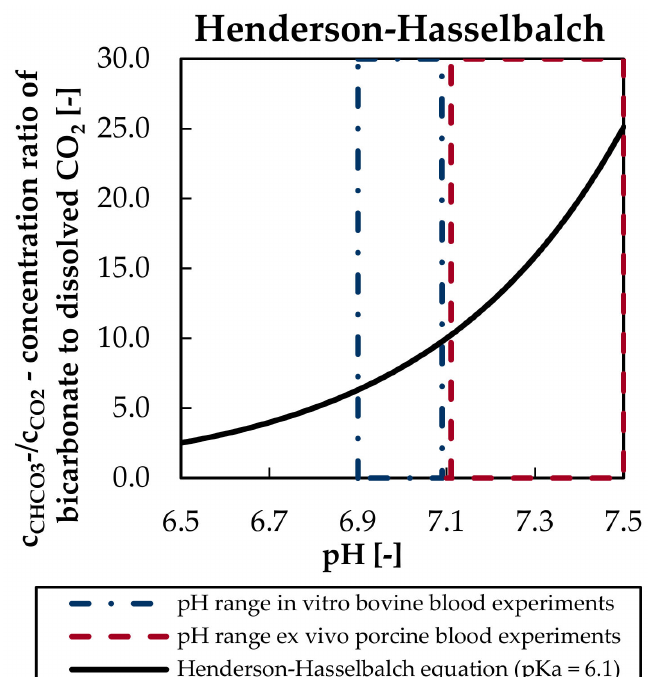
Figure 9. Ratio of bicarbonate to dissolved CO 2 concentration in dependency of the